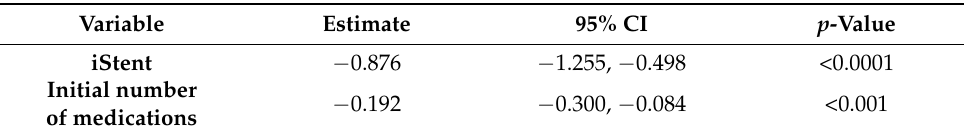
Table 6. Medication reduction multivariate